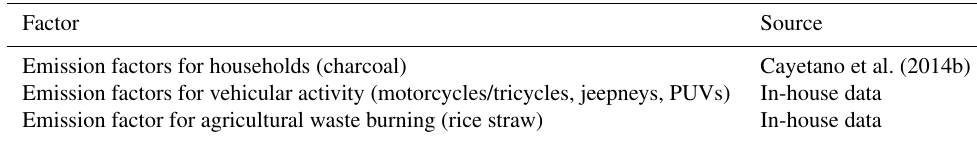
Table 1. Data sources for emission factors.